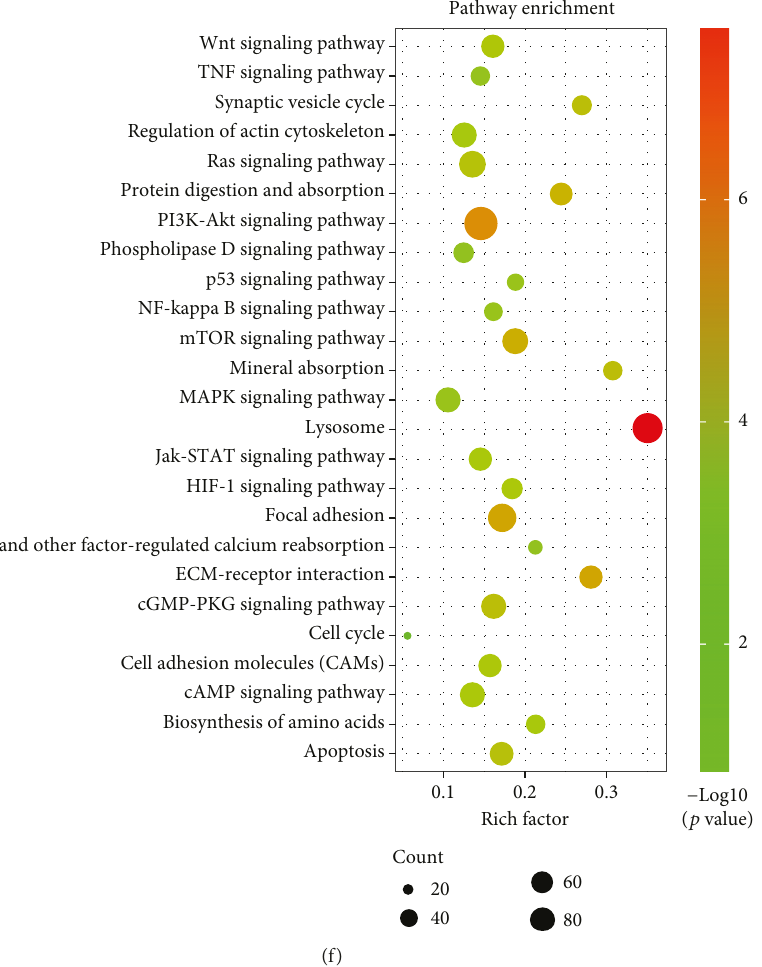
Figure 4: Comparison of global gene expression pro fi les between VICs and VDSCs. (a) Box plot shows the distribution of gene expression levels in each sample, and the dispersion of the data distribution can be observed; adipose mesenchymal stem cells (AdMSCs) were used for the reference. (b) Heat map for the Pearson correlation coe ffi cient of all gene expression levels between samples; the higher the correlation coe ffi cient indicates, the more similar the gene expression level. (c) Heat map for the global gene expression with group clusters ( n = 2 ). (d) Scatter plot of di ff erentially expressed genes (DEGs) in VDSCs versus VICs (upregulation: 301 and downregulation: 1294); FC foldchange > 1 was accepted as positive DEGs. (e) GO enrichment of those selected DEGs including the biological process (red), cellular component (blue), and molecular function (yellow); broken line indicates p value (-log10). (f) KEGG pathways enrichment bubble map; a larger p value (-log10) indicates a higher degree of